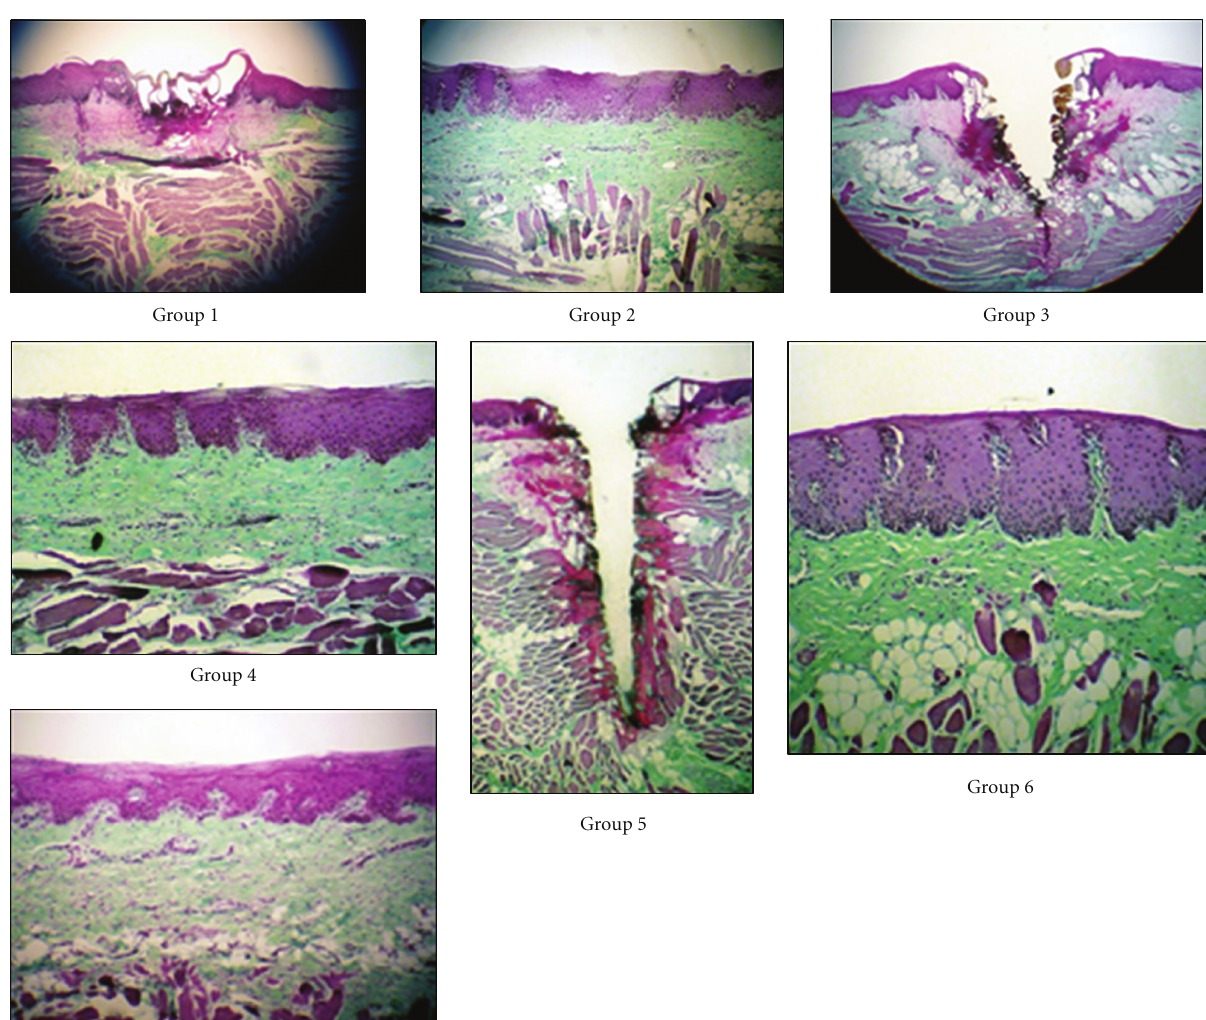
Figure 3: Histological finding of the groups at 10 × 10 magnification. Group 1: 1W defocused CO 2 laser irradiation. Group 2: 1W defocused CO 2 laser irradiation with absorption media. Group 3: 2W defocused CO 2 laser irradiation. Group 4: 2Wt defocused CO 2 laser irradiation with absorption media. Group 5: 3W defocused CO 2 laser irradiation. Group 6: 3W defocused CO 2 laser irradiation with absorption media. Group 7: Absorption media